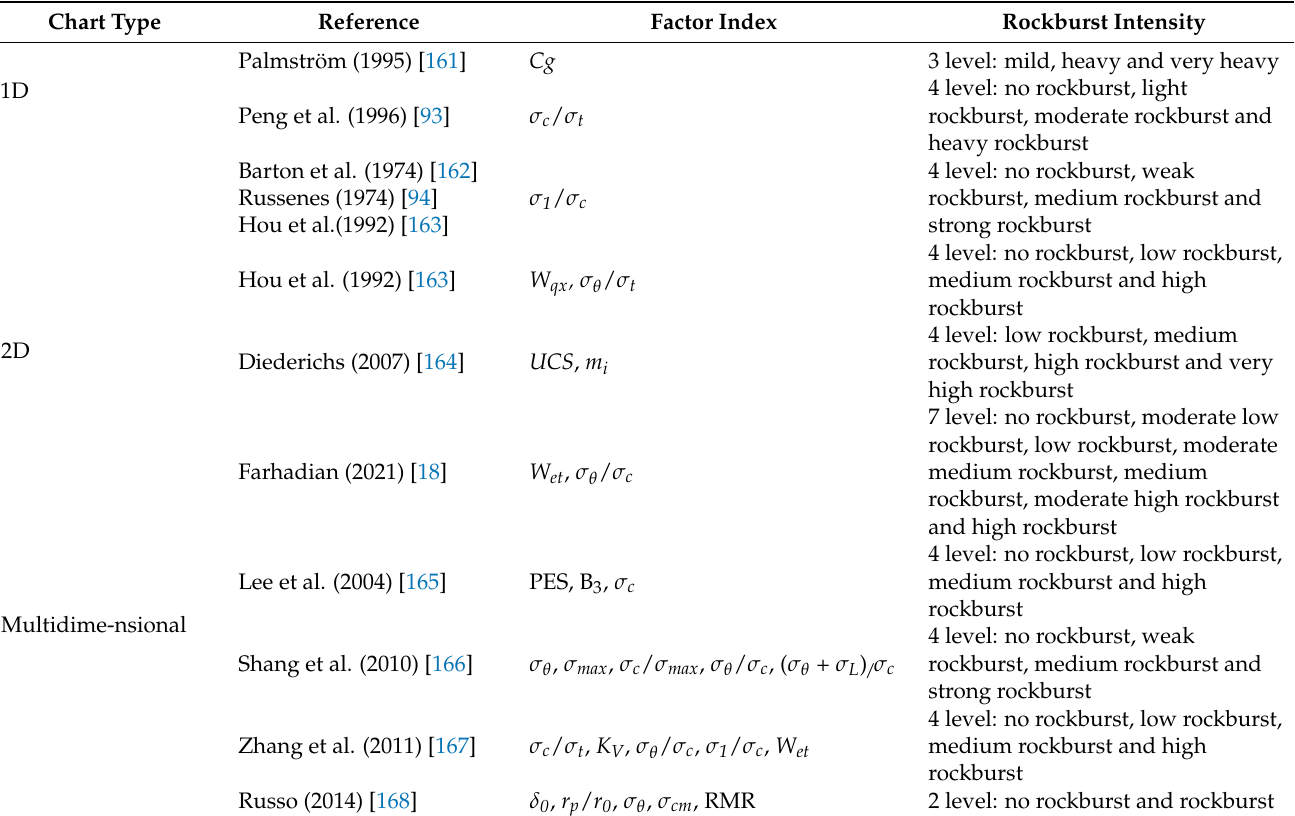
Table 6. Rockburst prediction classification